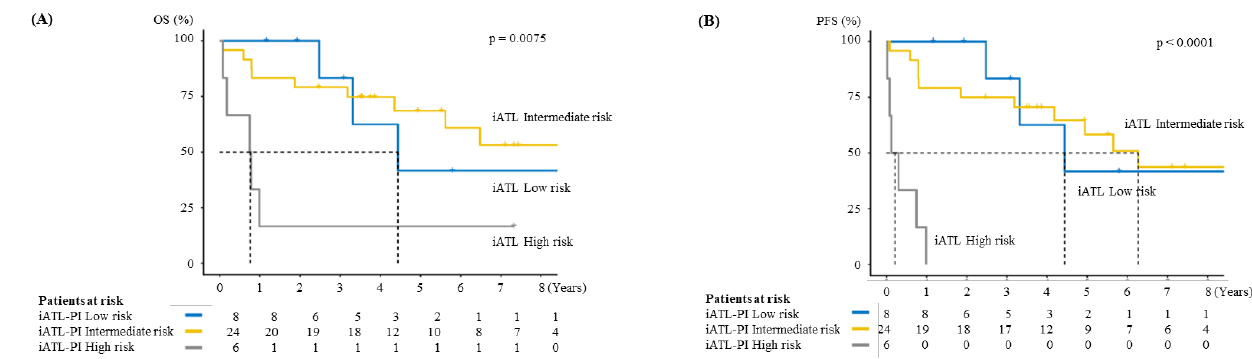
Figure 2. ( A ) Overall survival (OS) by indolent ATL-Prognostic Index (iATL-PI). ( B ) Progression-free survival (PFS) by